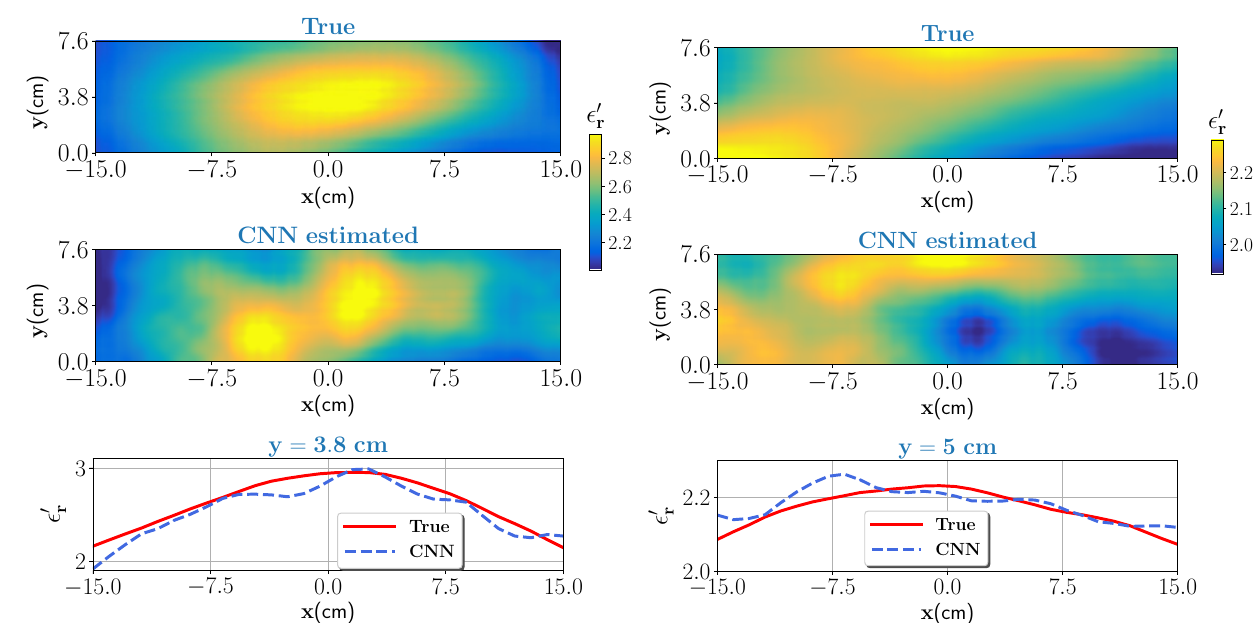
Figure 6. High moisture case with high variation (left column): top figure shows the true profile and middle figure is the estimate from the CNN. Bottom figure compares the pixel values for the true and estimated profile at y = 3.8cm data line. Nearly homogeneous case (right column): same caption except for the bottom figure where pixel values are compared for data line y = 5cm.